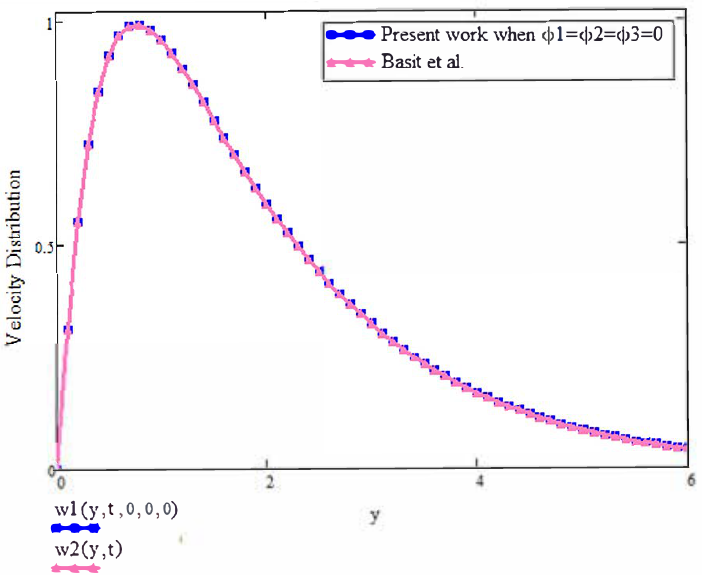
Figure 11. Comparison graph of velocity between present work and Basit et al. [2] when t = 2, a = 0.1, λ = 0, Gr = 15, β 1 =